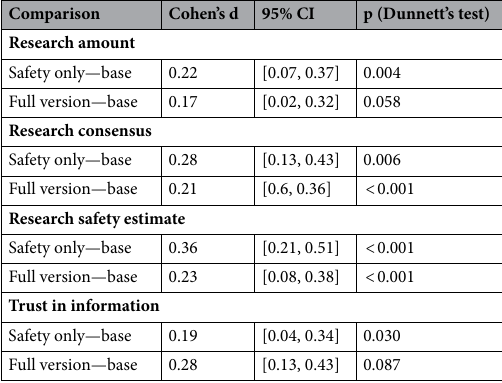
Table 2. Pairwise comparisons for significant effects.